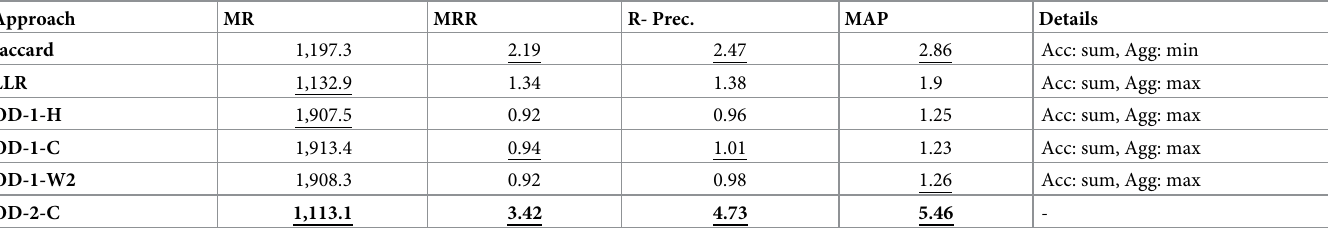
Table 6. Open discovery on time-sliced